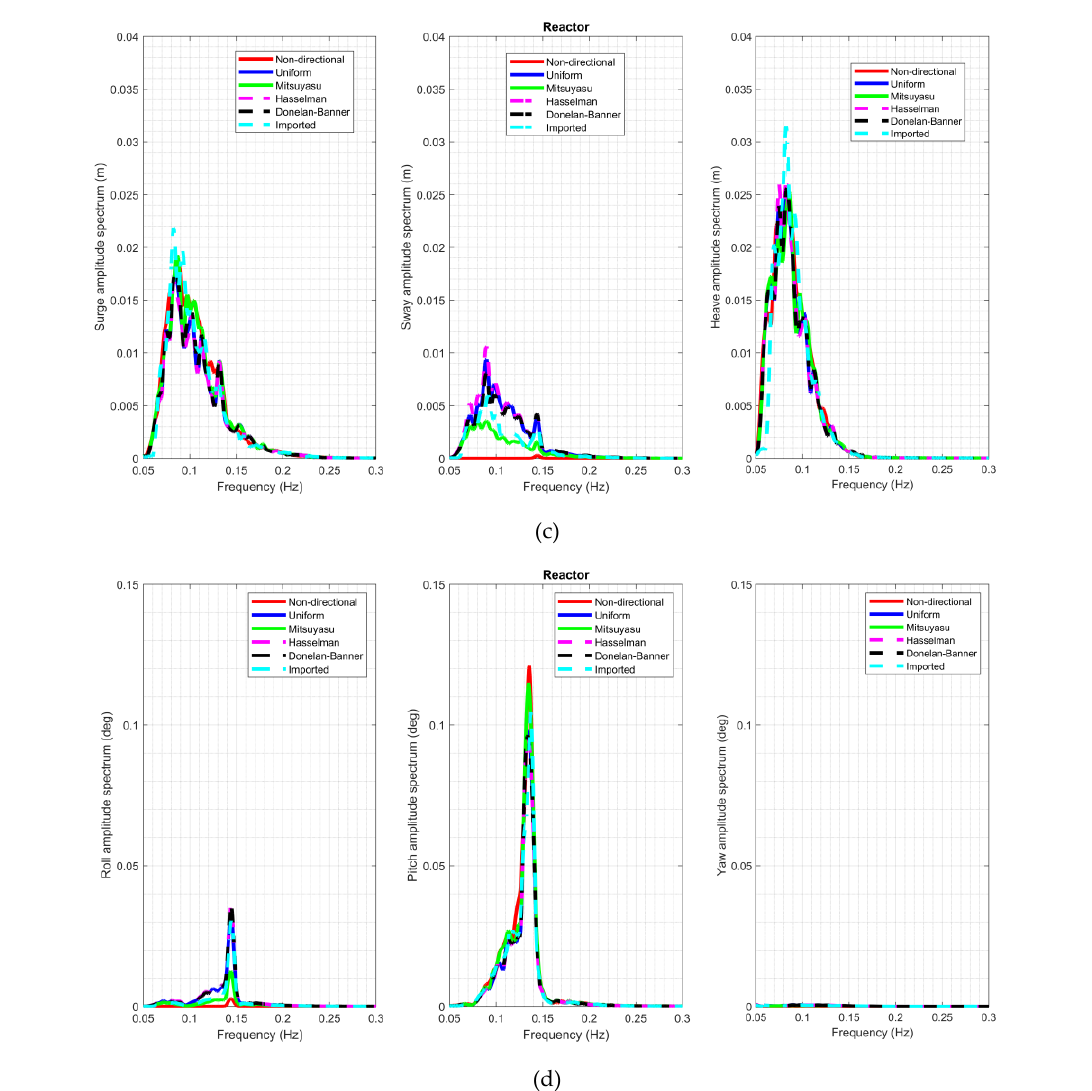
Fig. 8: Amplitude spectrum for all 6 degrees of freedom of the float (a,b) and of the reactor (c,d) for the different optimization